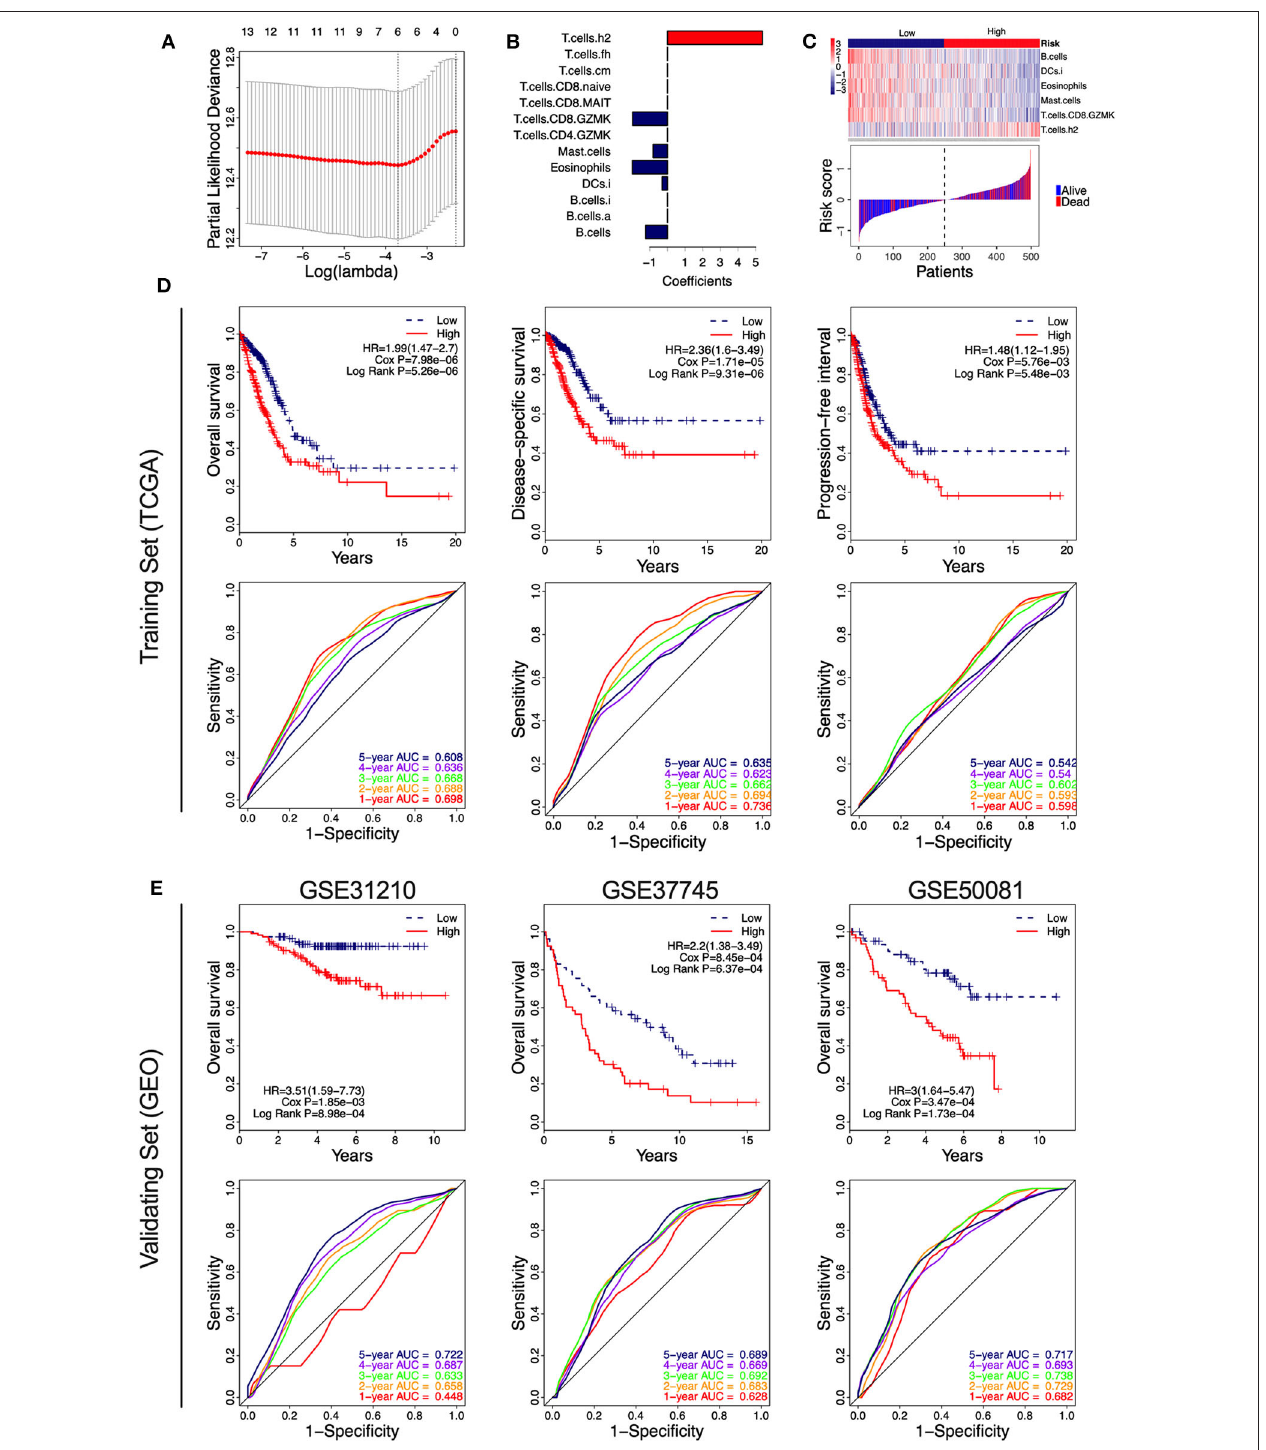
FIGURE 5 | Identification of the immune-cell characteristic score (ICCS) and investigation of its prognostic value in lung adenocarcinoma (LUAD). (A) Cross-validation for tuning parameter selection in the least absolute shrinkage and selection operator (LASSO) model. (B) LASSO coefficient profiles of 13 prognosis-related immune cell populations. Variables whose LASSO coefficient is not equal to zero were used as candidate variables to construct the ICCS model. (C) The ICCS model classifies patients into low-ICCS and high-ICCS groups. (D) Kaplan–Meier curves and time-dependent receiver operating characteristic (ROC) curves of the prognostic ICCS model in the training set [The Cancer Genome Atlas (TCGA)]. The association between the ICCS and the survival of patients was investigated using Cox regression and log-rank methods. (E) Kaplan–Meier curves and time-dependent ROC curves of the prognostic ICCS model in the validating set [three Gene Expression Omnibus (GEO)